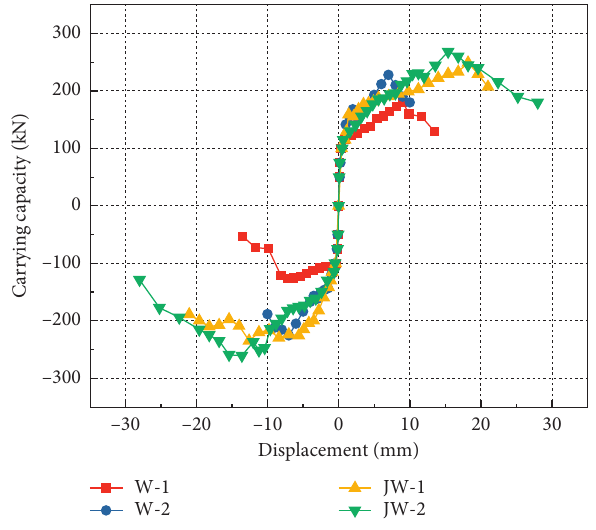
Figure 11: Skeleton curves of specimens.